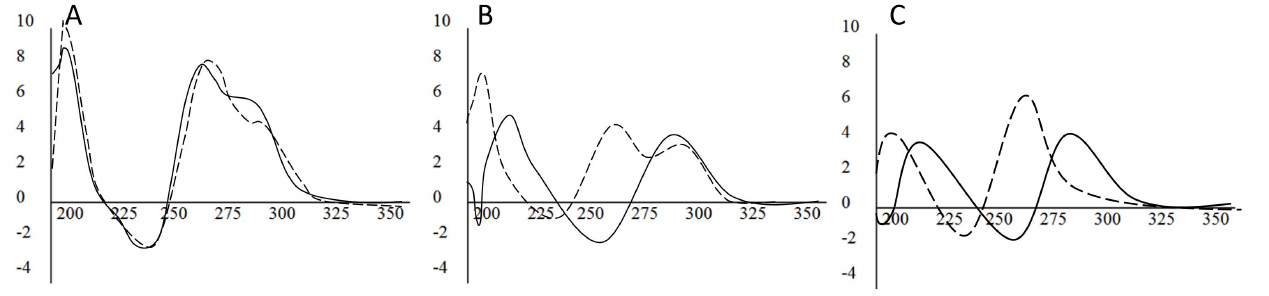
Figure 4. Comparison of methylated G4 conformation in different buffers. CD spectra for methylated oligonucleotides G4MEST1LM (A), G4MEST2M (B), and G4MEST3M (C) in NaPi, 50 mM KCl (solid line) or PCR buffer (dashed line). Molar ellipticity (x10 5 deg.cm 2 .dmol 2 1 ) is on the vertical axis and wavelength (nm) is on the horizontal